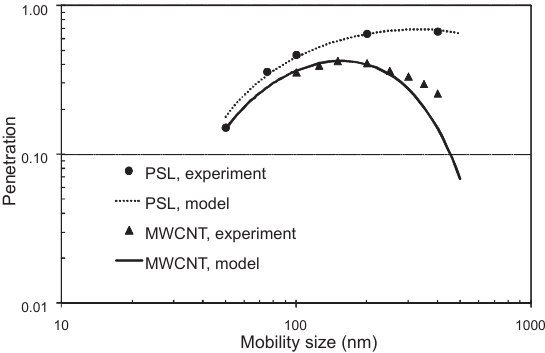
Fig. 6 Penetration as a function of the mobility size for PSL particles and multi-wall CNTs (MWCNTs). The symbols are experimental results and the curves are modeling